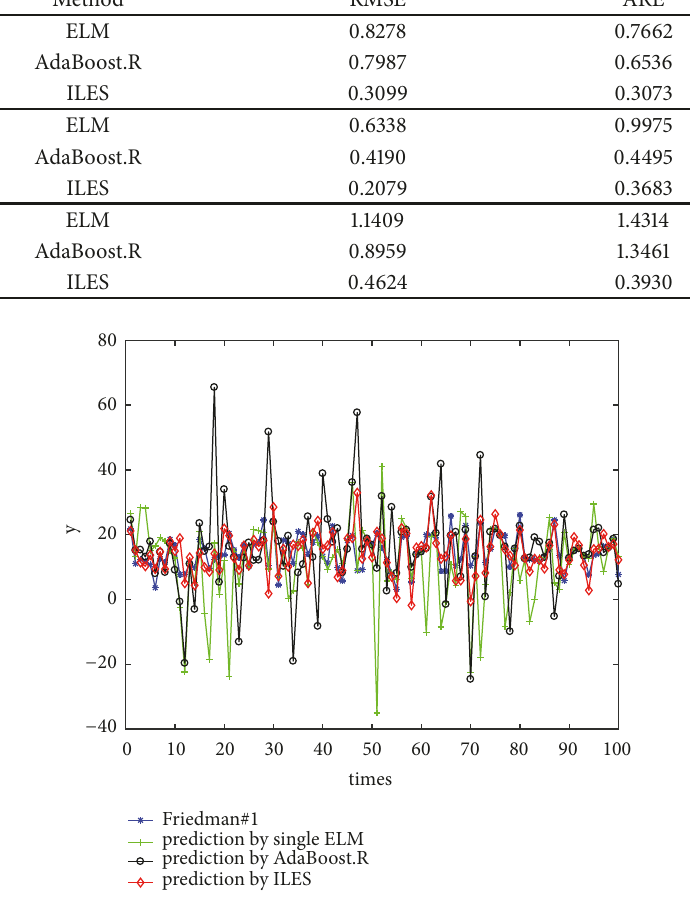
Figure 5: The comparison of Friedman#1 with different models.